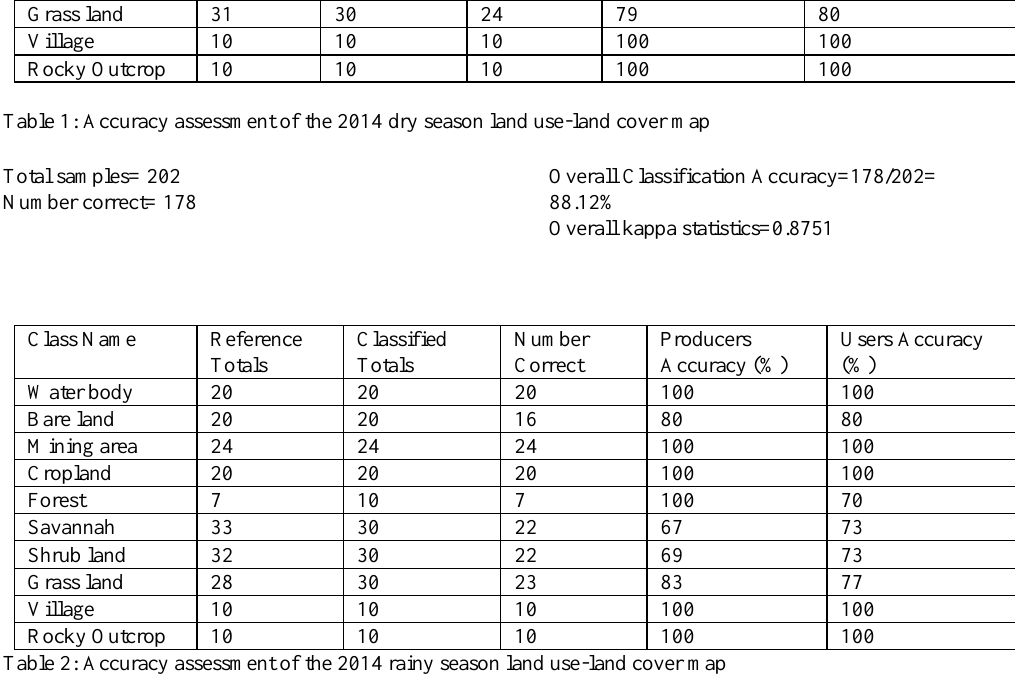
Table 2: Accuracy assessment of the 2014 rainy season land use-land cover